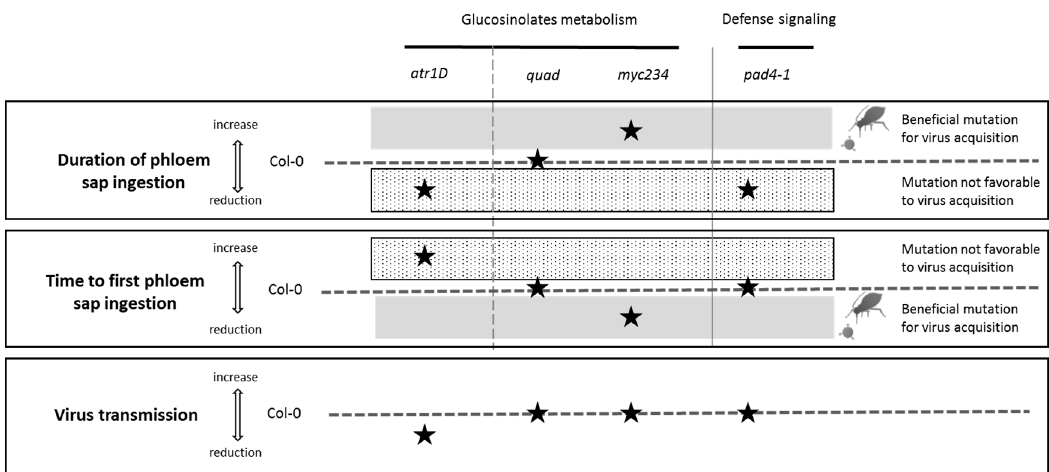
Figure 3. Schematic representation of the combined effect of A. thaliana mutations and TuYV infection on phloem sap ingestion, time until the first sap ingestion phase, and virus transmission. Black stars stand for the effect of the mutation in TuYV-infected A. thaliana when compared to the reference Col-0 represented by a dashed line. When the stars are above the line, the parameter values observed for the mutants are higher than those for Col-0 and when the stars are below the line, the values are lower than those for Col-0. In grey is a zone that potentially represents beneficial conditions for virus acquisition (long sap ingestion and short delay to perform the first sap ingestion phase). The dotted line area symbolizes a zone not favorable for virus acquisition with reduced sap ingestion and increased time until the first sap ingestion phase.